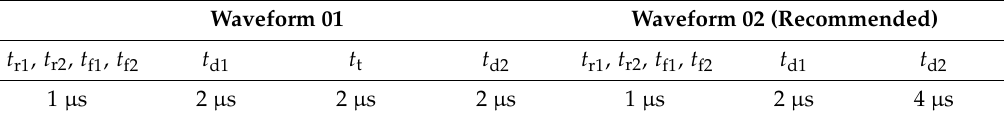
Table 1. Optimized parameters of both waveforms for suppressing residual vibrations.